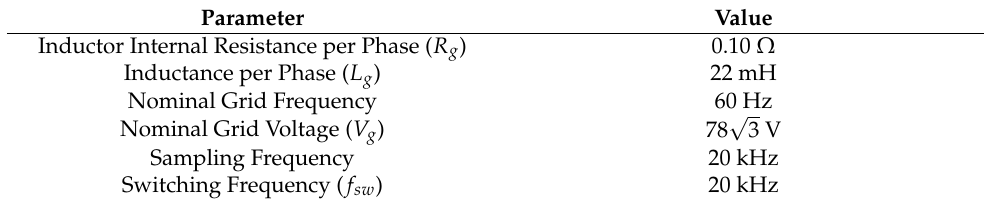
Figure 18. Dynamic response for voltage variation: ( a ) DC voltage response; ( b ) active power response. Table 4. Three-phase power inverter